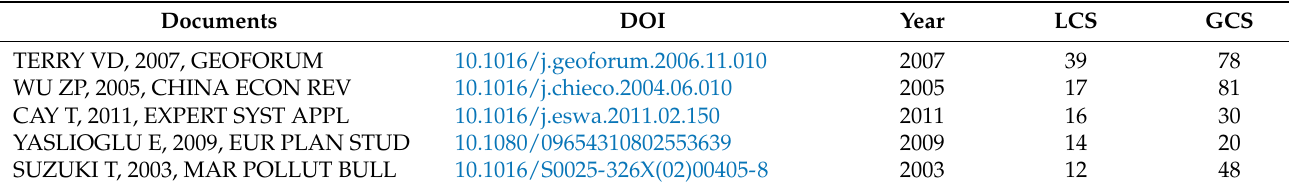
Table 1. Top 10 local citation scores (LCS) in land consolidation